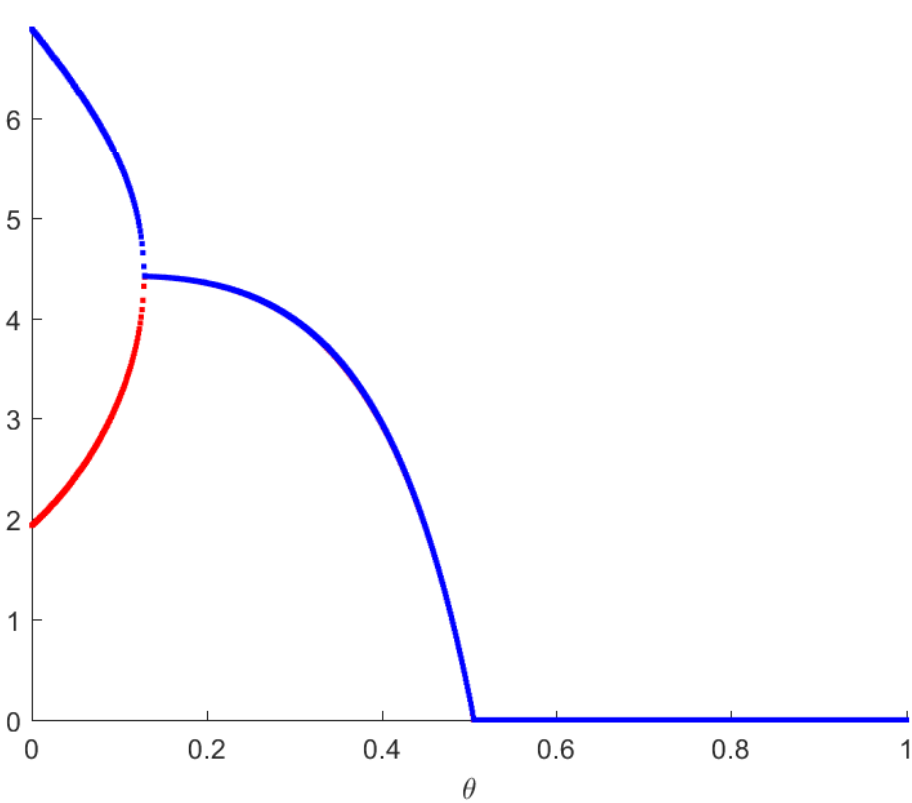
Figure 1. Bifurcation diagram of RPW system (1) with respect to θ